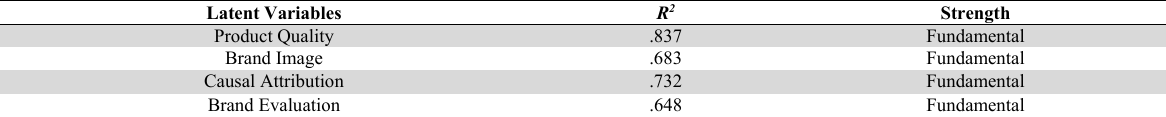
R 2 Analysis of Variance: